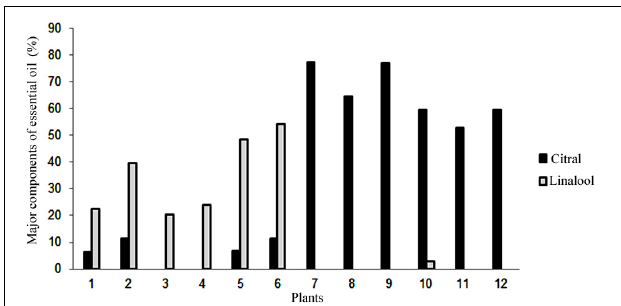
FIGURE 4 | Percentage of the major essential oil content detected by gas chromatography. Mother diploid plant (7), synthetic triploid plants (1–6) and synthetic tetraploid plants (8–12). Gray bars, Citral; Black bars,